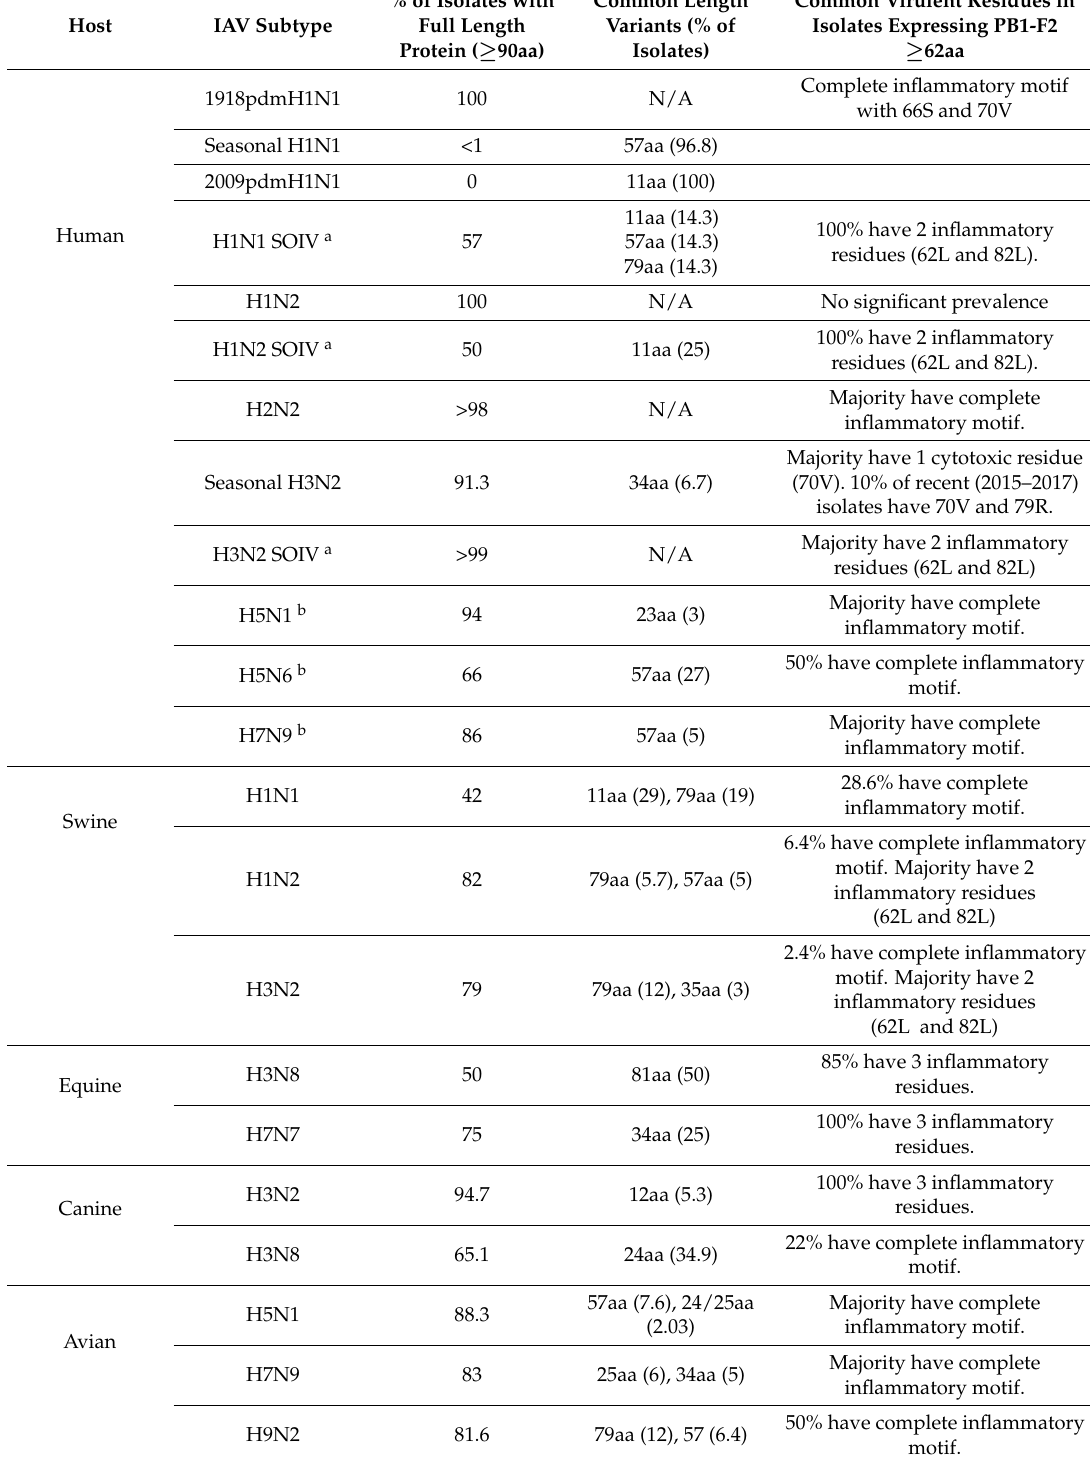
Table 1. Common length and virulent sequence variants of IAV